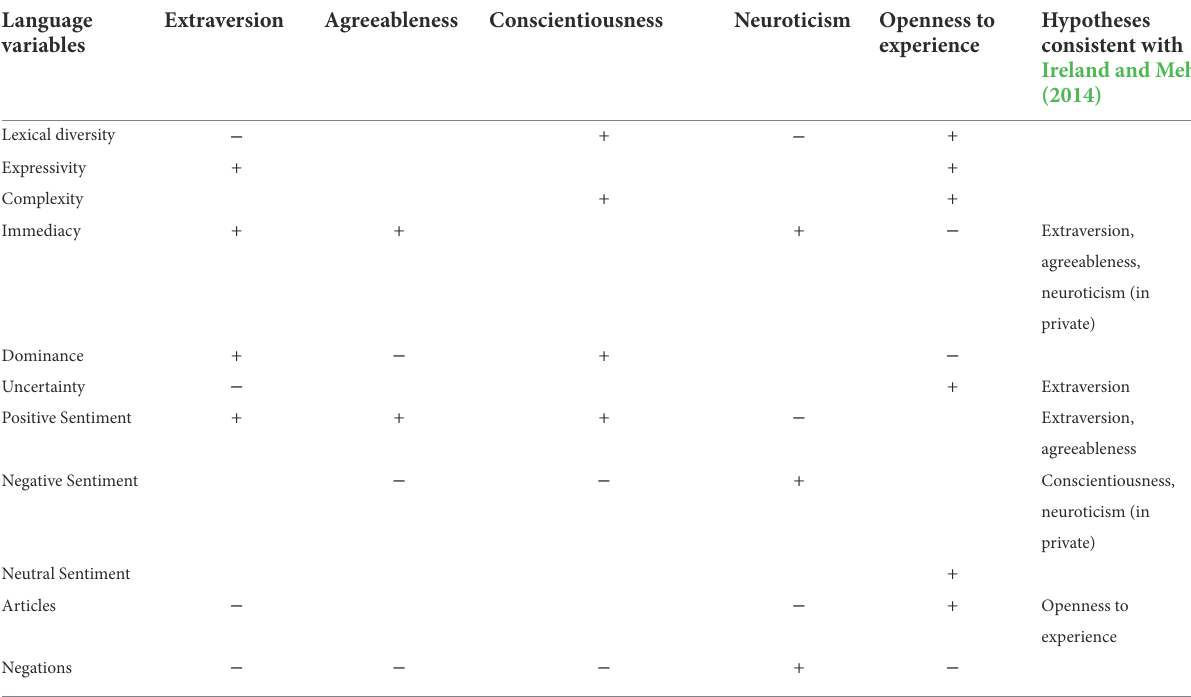
TABLE 2 Summary of